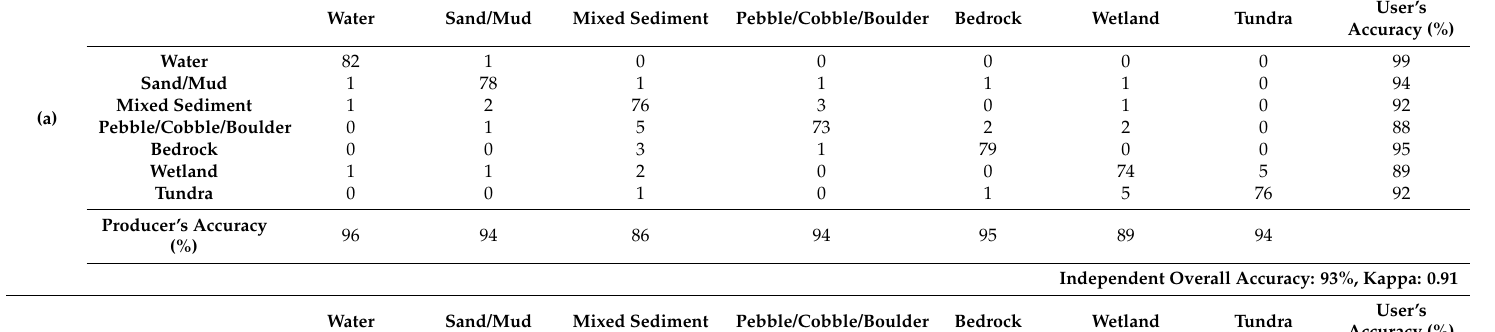
Table 10. Confusion matrices generated from three Random Forest models generated with all Landsat 5: quad pol RADARSAT-2, and CDED variables (a); Landsat 5 and CDED variables (b); and quad pol RADARSAT-2 and CDED variables